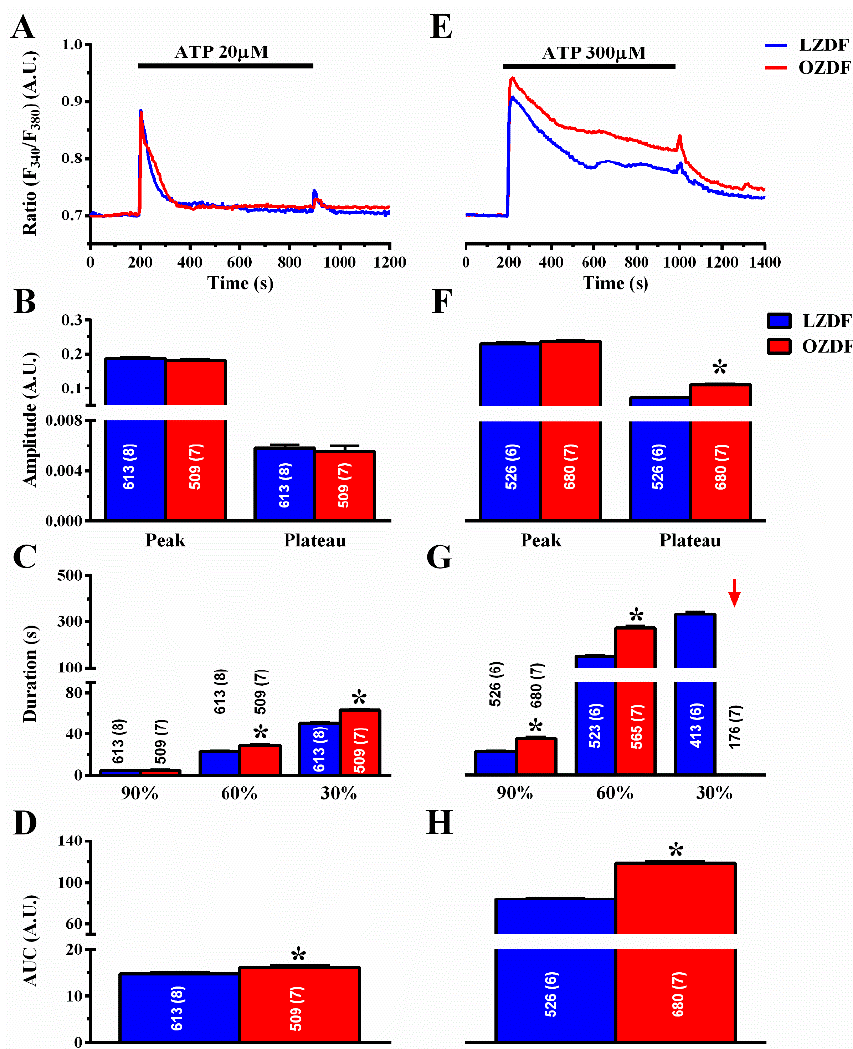
Figure 3. The Ca 2 + response to low and high doses of the physiological agonist, ATP, is increased in native aortic endothelium of obese Zucker diabetic fatty rats. ( A ) Representative recordings of the Ca 2 + response to 20 µ M ATP in LZDF (blue line) and OZDF rats (red line). ( B ) Mean ± SE of the peak and plateau phase of the Ca 2 + response to 20 µ M ATP in LZDF and OZDF rats. ( C ) Mean ± SE of the duration of the Ca 2 + response to 20 µ M ATP in LZDF and OZDF rats. The asterisk indicates p < 0.05. ( D ) Mean ± SE of the AUC of the Ca 2 + response to 20 µ M ATP in LZDF and OZDF rats. ( E ) Representative recordings of the Ca 2 + response to 300 µ M ATP in LZDF and OZDF rats. ( F ) Mean ± SE of the peak and plateau phase of the Ca 2 + response to 300 µ M ATP in LZDF and OZDF rats. The asterisk indicates p < 0.05. ( G ) Mean ± SE of the duration of the Ca 2 + response to 300 µ M ATP in LZDF and OZDF rats. The asterisk indicates p < 0.05. Red arrow indicates that the Ca 2 + signal failed to reach the clearing rate to the 30% of the initial peak amplitude in OZDF rats. ( H ) Mean ± SE of the AUC of the Ca 2 + response to 300 µ M ATP in LZDF and OZDF rats. The asterisk indicates p < 0.05, Mann-Whitney test.